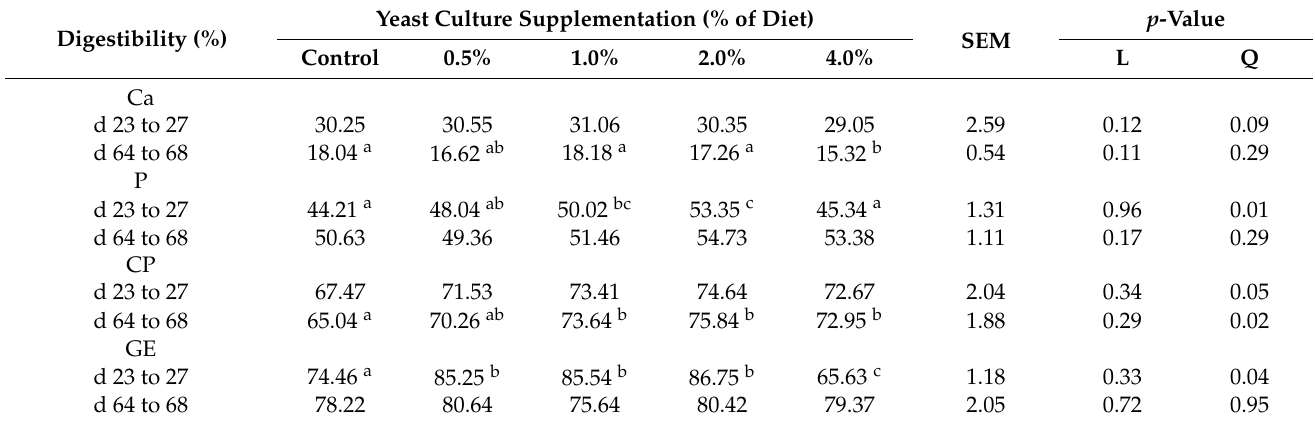
Table 4. Effect of yeast culture supplementation in goose diets on nutrient digestibility.